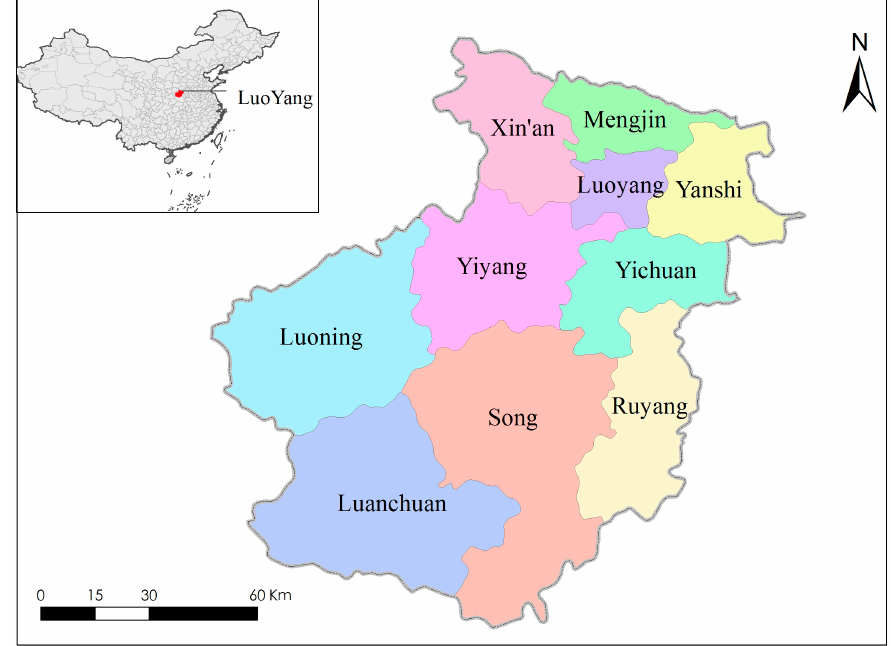
Figure 2. Administrative divisions of Henan Province.